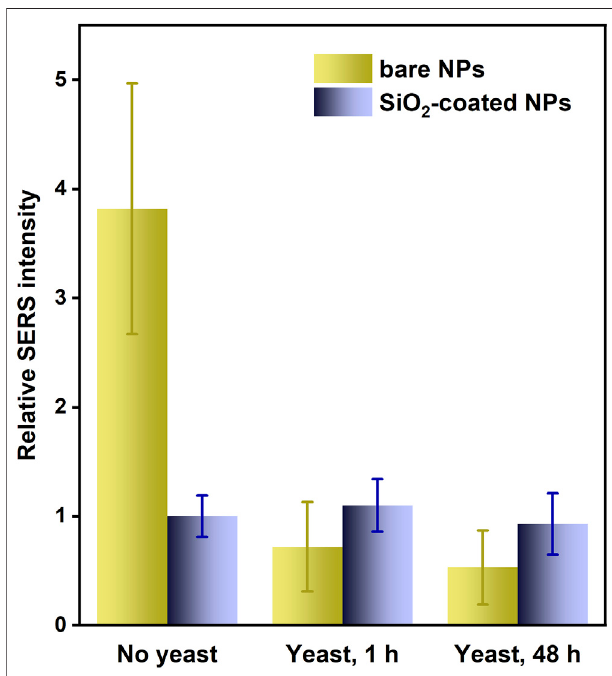
Fe 3 O 4 /Ag@MES@SiO 2 nanomaterial (compare the height of the respective yellow and navy blue bars in Figure 10 ). On the